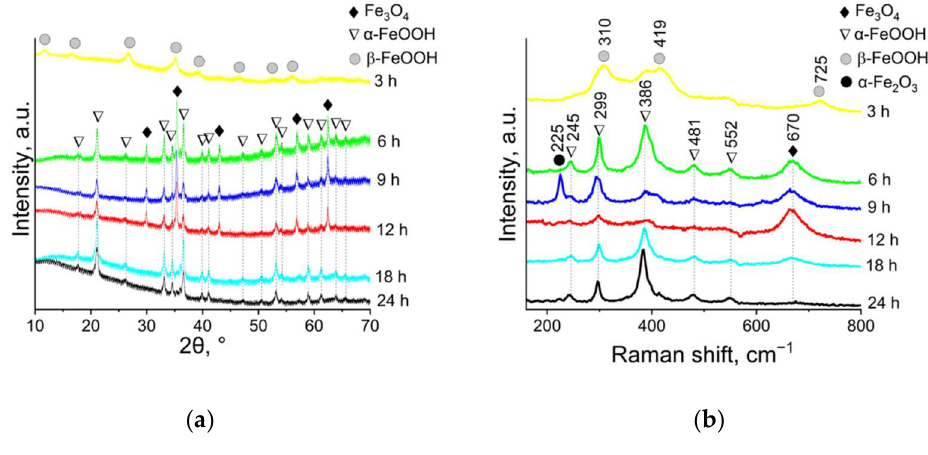
Table 1. Phase composition of the samples at different time of the synthesis.